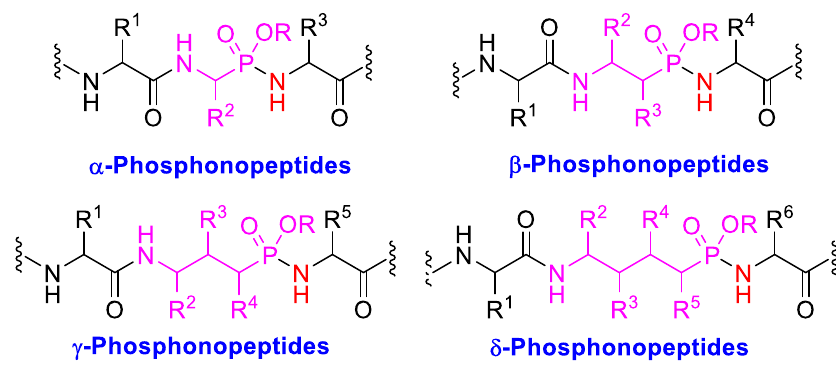
Figure 1. Different classes of phosphonopeptides.